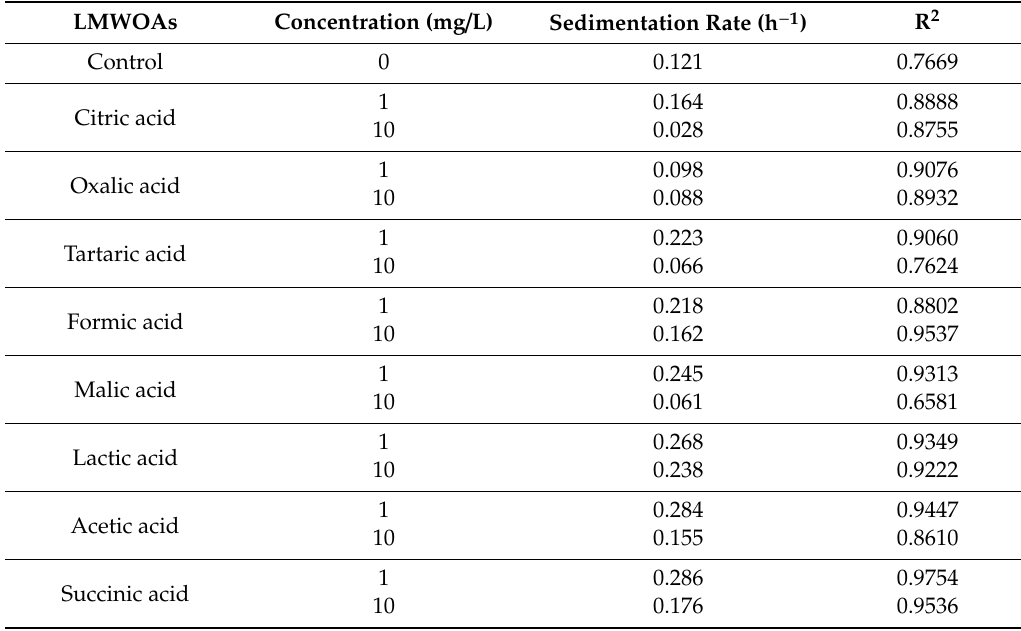
Table 1. Dynamic fitting of CuO NP sedimentation with different LMWOAs contents in aqueous solution. LMWOAs Concentration (mg /